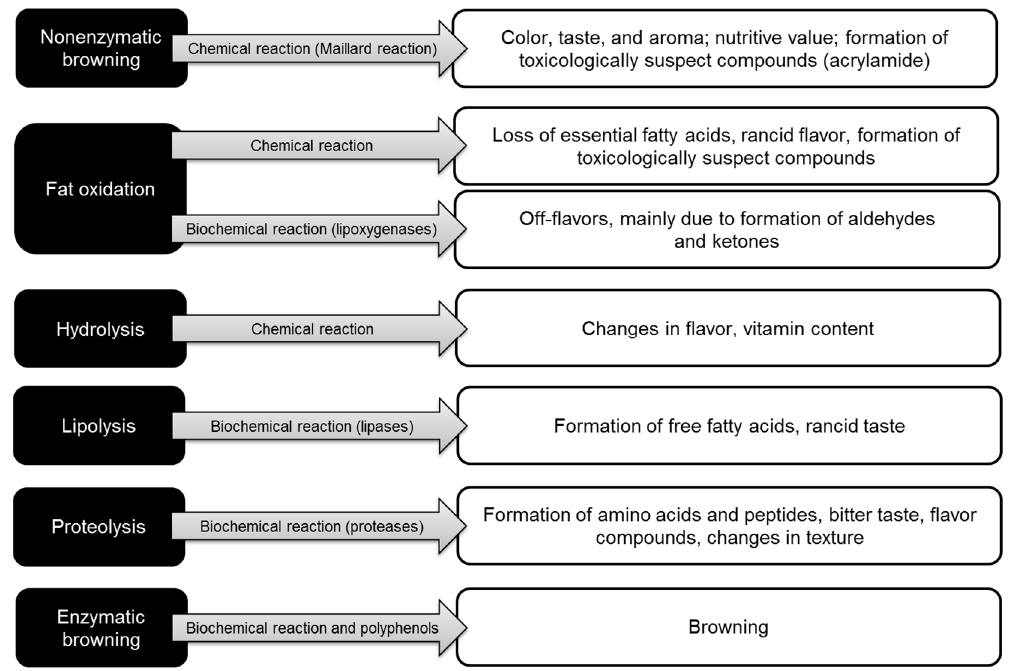
Figure 6. Chemical/biochemical reactions in foods affecting their quality [135]. Foods 2020 , 9 , x FOR PEER REVIEW